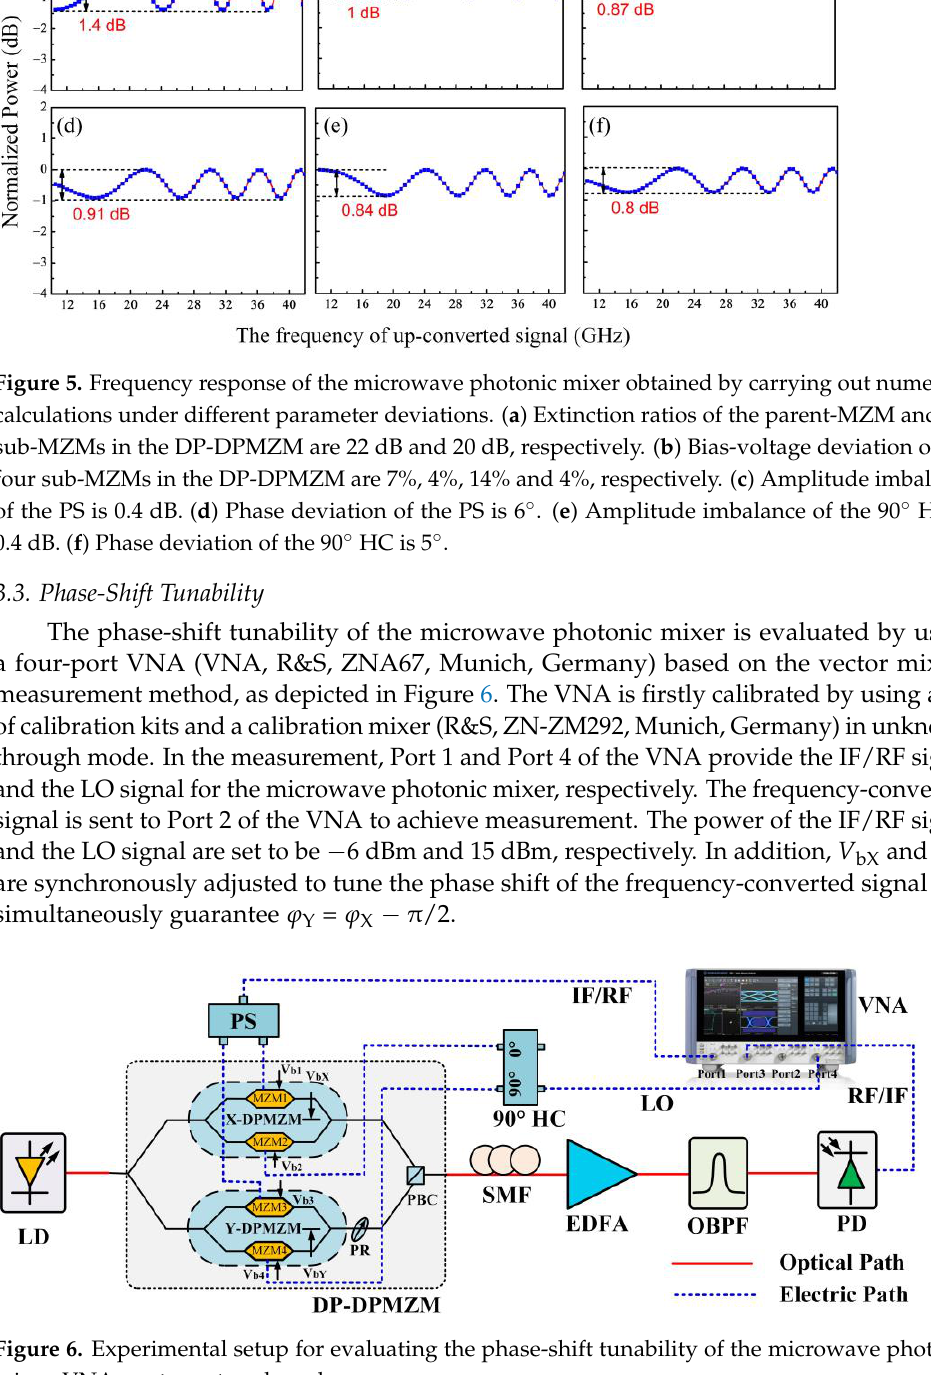
Figure 6. Experimental setup for evaluating the phase-shift tunability of the microwave photonic mixer. VNA, vector network analyzer.